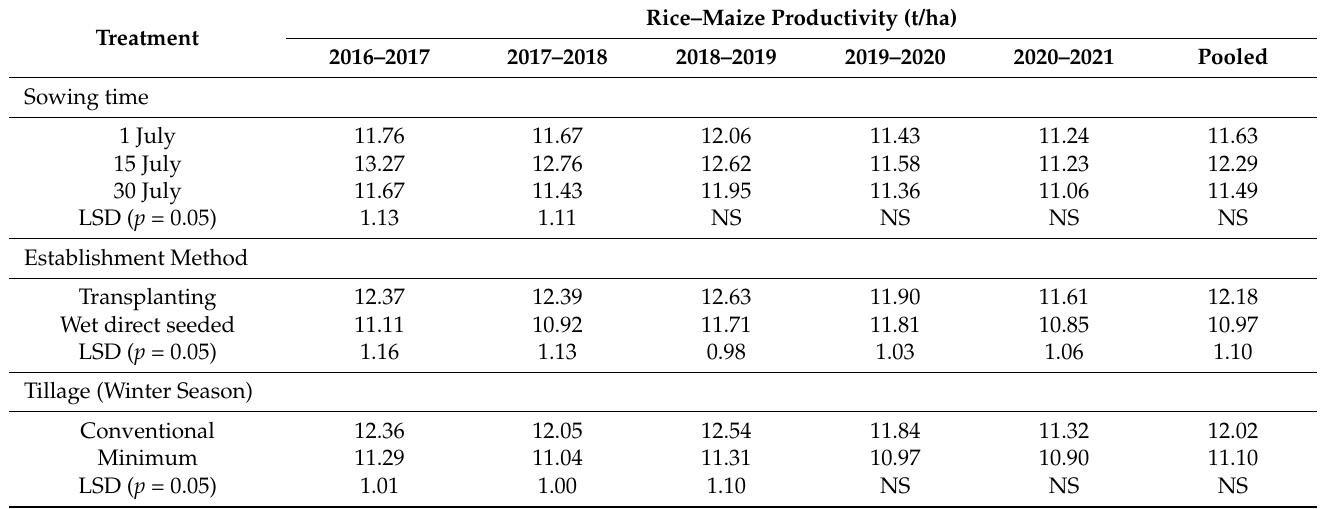
Table 5. Economics of rice, maize and rice–maize system during the 5-year period. Cost of Cultivation Treatment